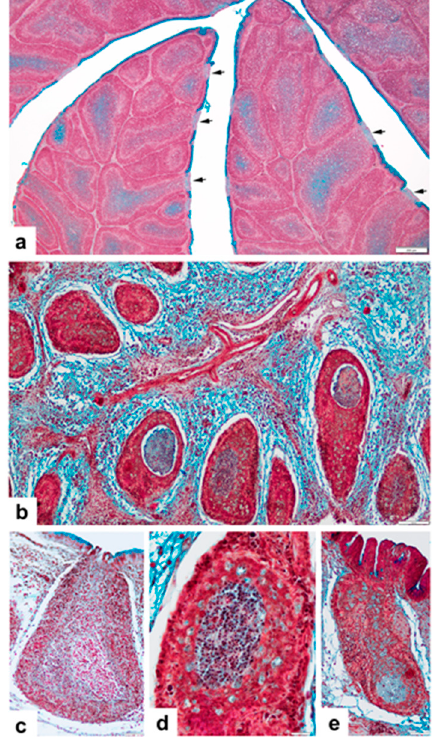
Figure 2. Movat pemtachrome staining of bursa of Fabricius ( a ) Non-vaccinated, non-challenged (NV-NC) group of chickens. The cells of IFE and FAE are Movat positive and negative (arrows), respectively. In the medulla, the staining intensity of extracellular gp is variable. ( b ) Non-vaccinated, challenged (NV-C) group of chickens. Four days pi, a very virulent IBDV-infected bird. Detail of a bursal fold. The follicles shrank, in several follicular medulla, different stages of segregation emerged, and the interfollicular connective tissue (ICT) remarkably increased. ( c ) At 36 h pi. The follicular medulla shows an area (outlined) where the cell density may be lower. The cortex is intact. ( d ) Four days pi. The segregated area is densely packed with cells and large, Movat-positive cells (Mal) found around the segregated area. Cortex is highly depleted. ( e ) The surface epithelium is wavy, and the gp production ceased in the IFE, but a large number of Movat-positive Mal(s) occupy the medulla. Mal may be fused with the segregated area which is filled with a Movat-positive substance. Mal are also present in the depleted cortex.